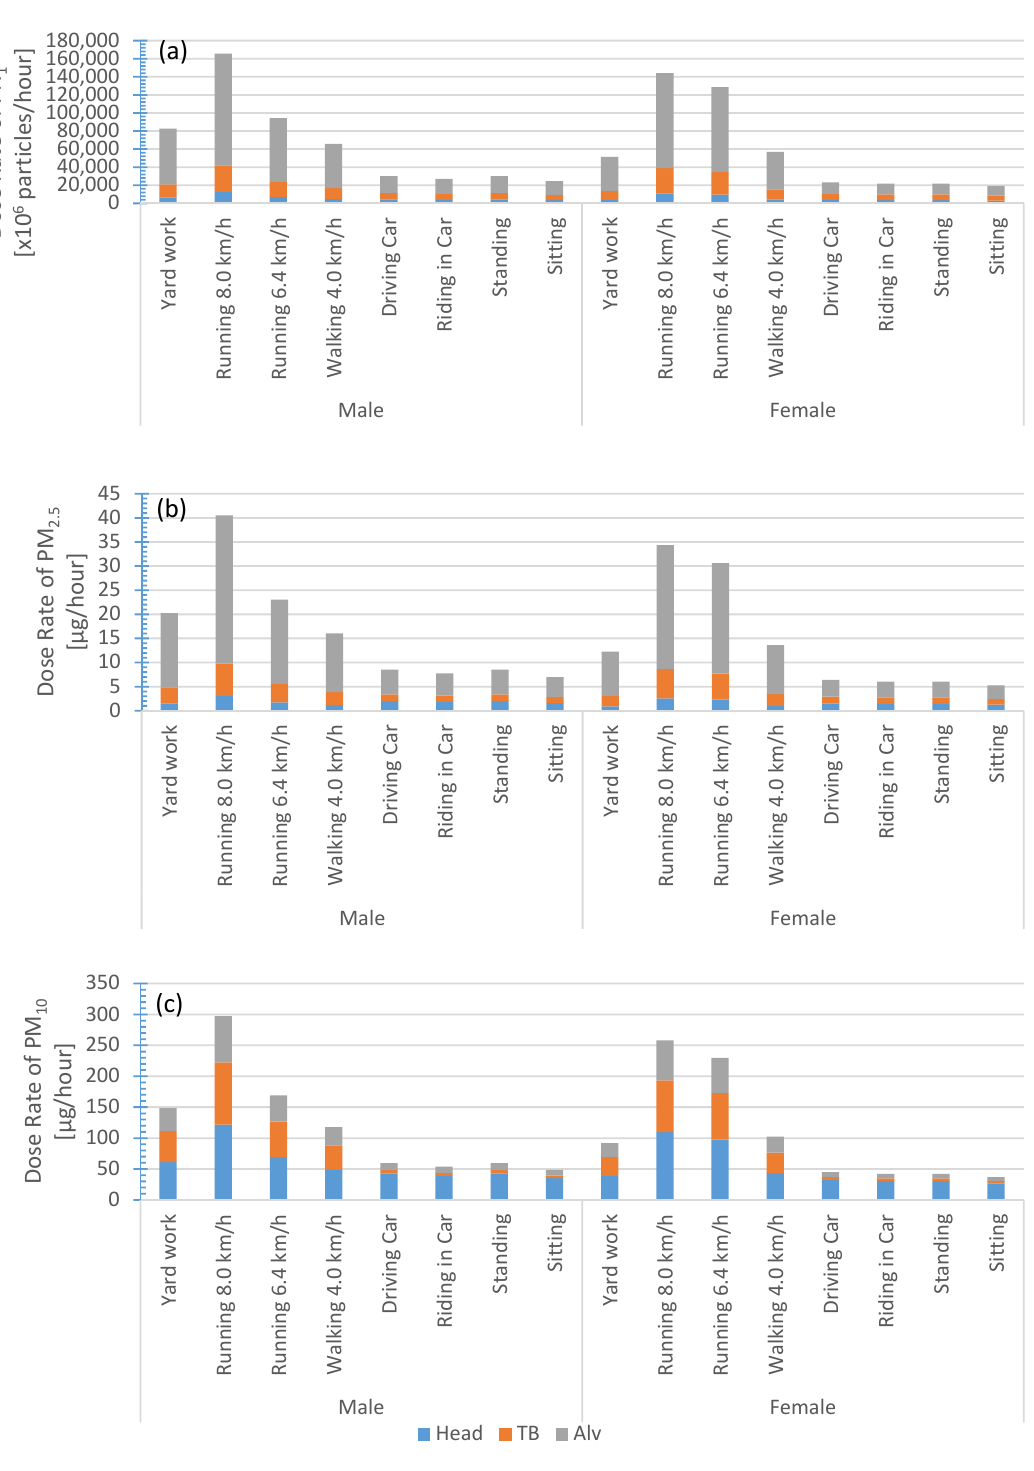
Figure 5. University of Jordan campus; regional inhaled deposited dose rates calculated for di ff erent activities and genders: ( a ) submicron particle number concentration and ( b , c ) particulate matter PM 2.5 and PM 10 . The color legend is: (blue) head airways, (red) tracheobronchial, and (green)